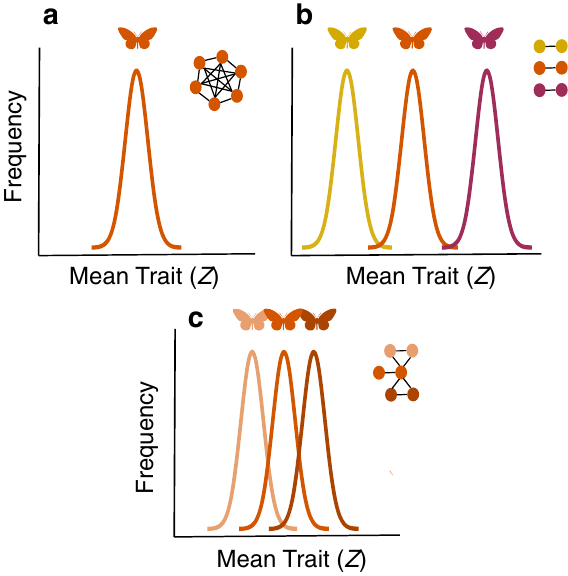
Figure 2. A conceptual example of the expected frequencies of traits values (Z), here representing the color pattern of the butterflies, for distinct scenarios of species specialization in habitats. Circles represent species and species that co-occur are represented by links. (a) All species occur in all habitats. In this case only one ring is formed. (b) Distinct species occur in different habitats, each species being habitat specialist. In this case all species in each habitat formed a mimicry ring. (c) One species is habitat generalist occurring in all habitats— supergeneralist species. In this case each habitat formed a mimicry ring, however their trait values are very